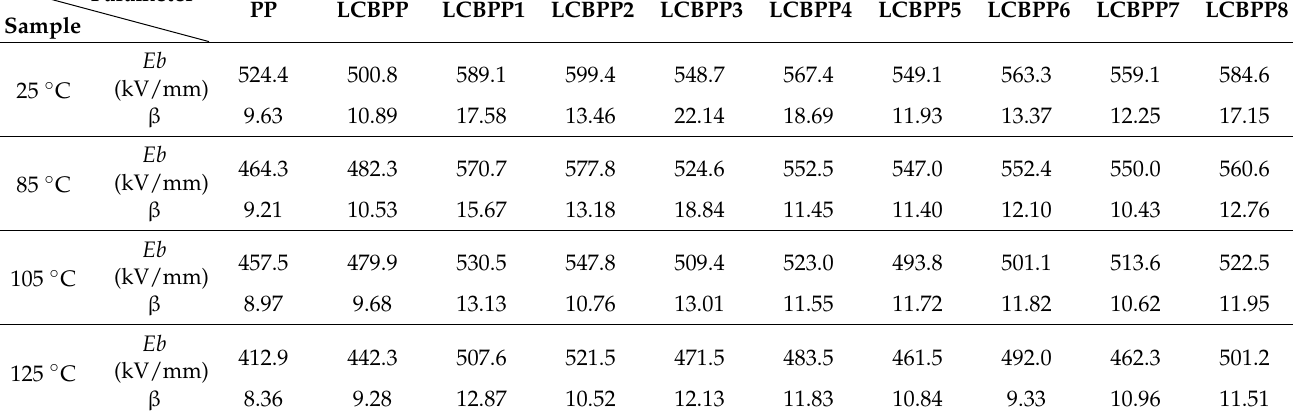
Table 4. The breakdown parameters of test